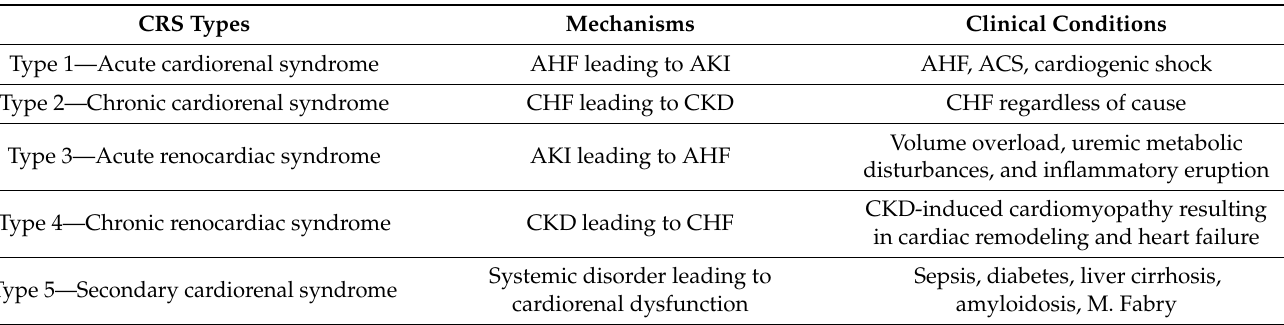
Table 1. Classification and basic characteristics of cardiorenal syndrome (CRS). AHF: acute